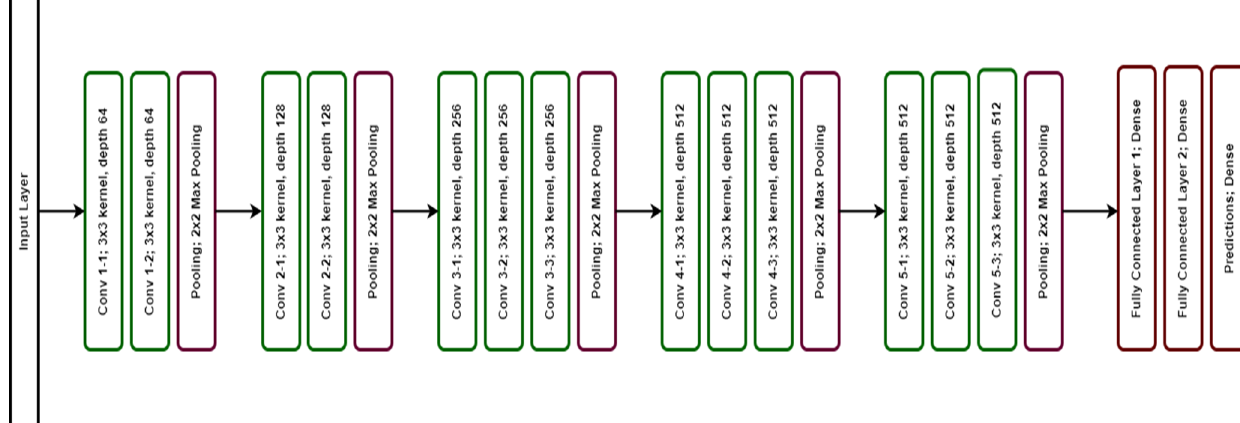
Figure 3. Block schematic of the VGG16 architecture.